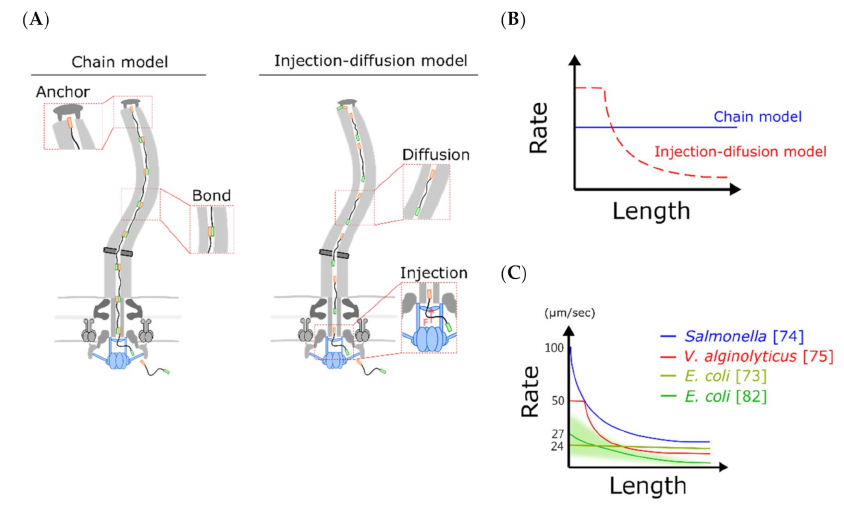
Figure 4. Potential mechanisms of the flagellar growth process. ( A ) Schematics of the chain model (left) and the injection-di ff usion model (right) are shown. The chain model proposed that sequential flagellins are linked head-to-tail to form a chain, and the first flagellin anchors beneath the distal end of the flagellum to provide a pulling force. Therefore, constant force contributes to a constant growth rate. According to the injection-di ff usion model, the secretion system applies a secretion force on an unfolded flagellin, and flagellins are delivered through di ff usion after entering the channel. Hence, flagellins are crowded on the channel when the flagellum is getting longer. ( B ) The chain model predicts a constant growth rate, and the injection-di ff usion model predicts a length-dependent growth rate. ( C ) The summary of flagellar growth rate of three bacteria using fluorescent-based